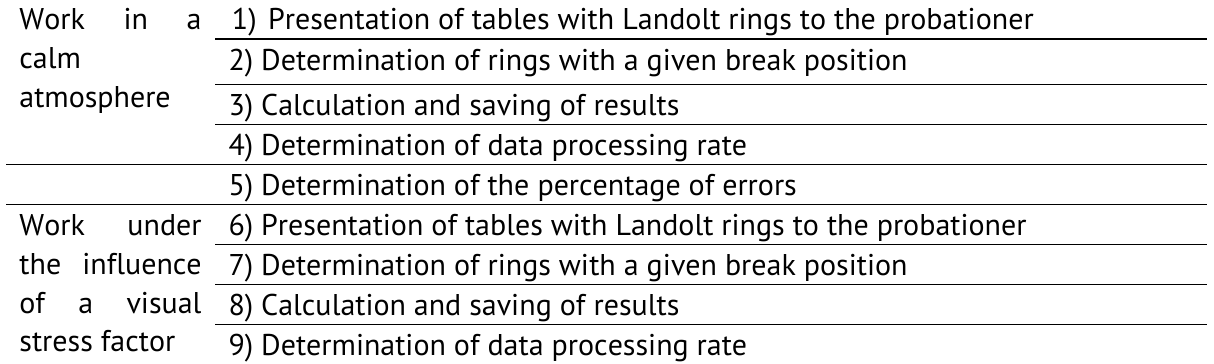
The algorithmic diagram of testing under the stress